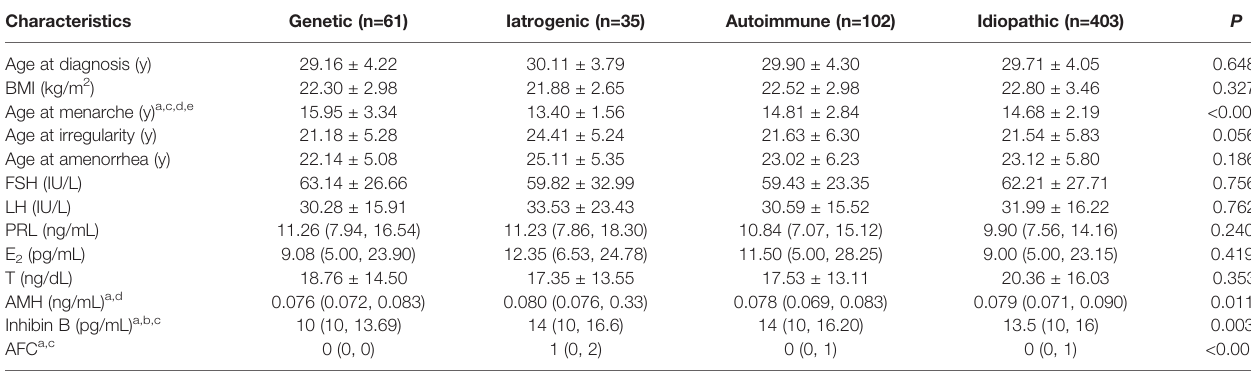
TABLE 4 | Characteristics of POI patients within different etiologies.